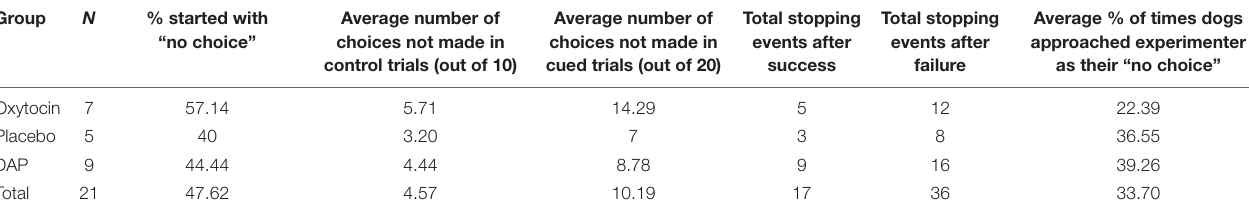
TABLE 7 | Total number of dogs who made less than the total number of attempts set in the test (i.e., < 30), the percentage of these dogs that started the OCT with a “No Choice”, the total number of stopping events after successes and failures, and the percentage of these dogs who approached the experimenter at least once during their “Stopping